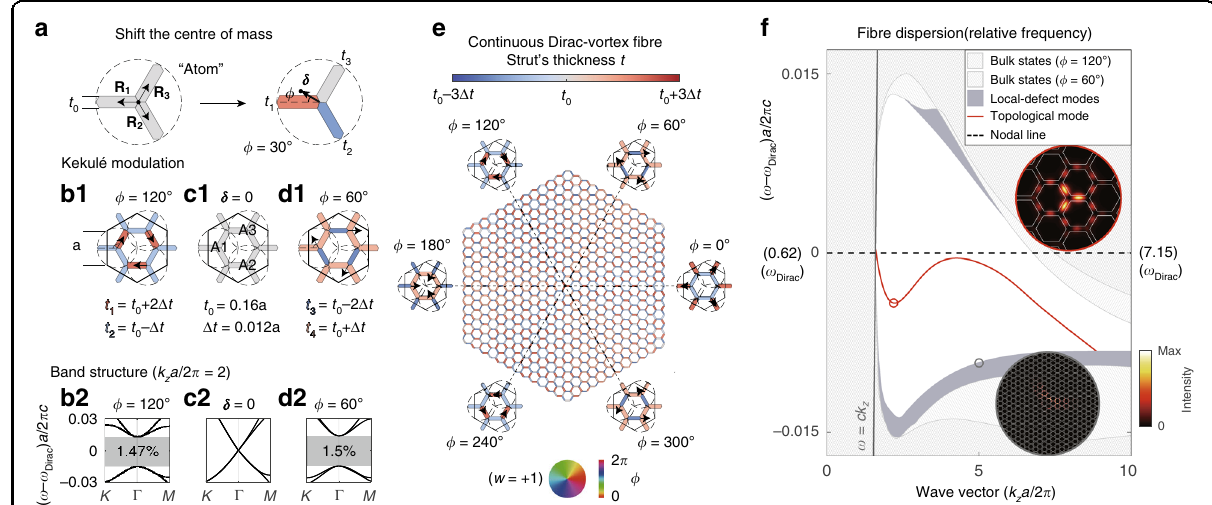
Fig. 3 Dirac-vortex fi bre obtained by continuous Kekulé modulations. a Example of how an “ atom ” can be shifted in any direction (arg[ δ ] = ϕ ) with fi nite amplitude (| δ |) by changing the widths of the three struts. ( b1 ), ( c1 ), ( d1 ) Supercell examples of three coordinated atoms (A1, A2, and A3) ffiffiffi p ffiffiffi p ffiffiffi p j δ j t = a ¼ 0 : 012 a . The corresponding band structures are with j δ j ¼ 3 a = 80, ϕ = 120°; | δ | = 0; and j δ j ¼ 3 a = 80, ϕ = 60°, respectively. Δ t ¼ 2 3 0 plotted in ( b2 ), ( c2 ), and ( d2 ), respectively. e Structure of a continuous Dirac-vortex PCF, in which every strut is coloured according to its width. f Band diagram of the fi bre plotted in reference to the frequency of the original nodal-line (central dashed line). The inset shows the intensity patterns